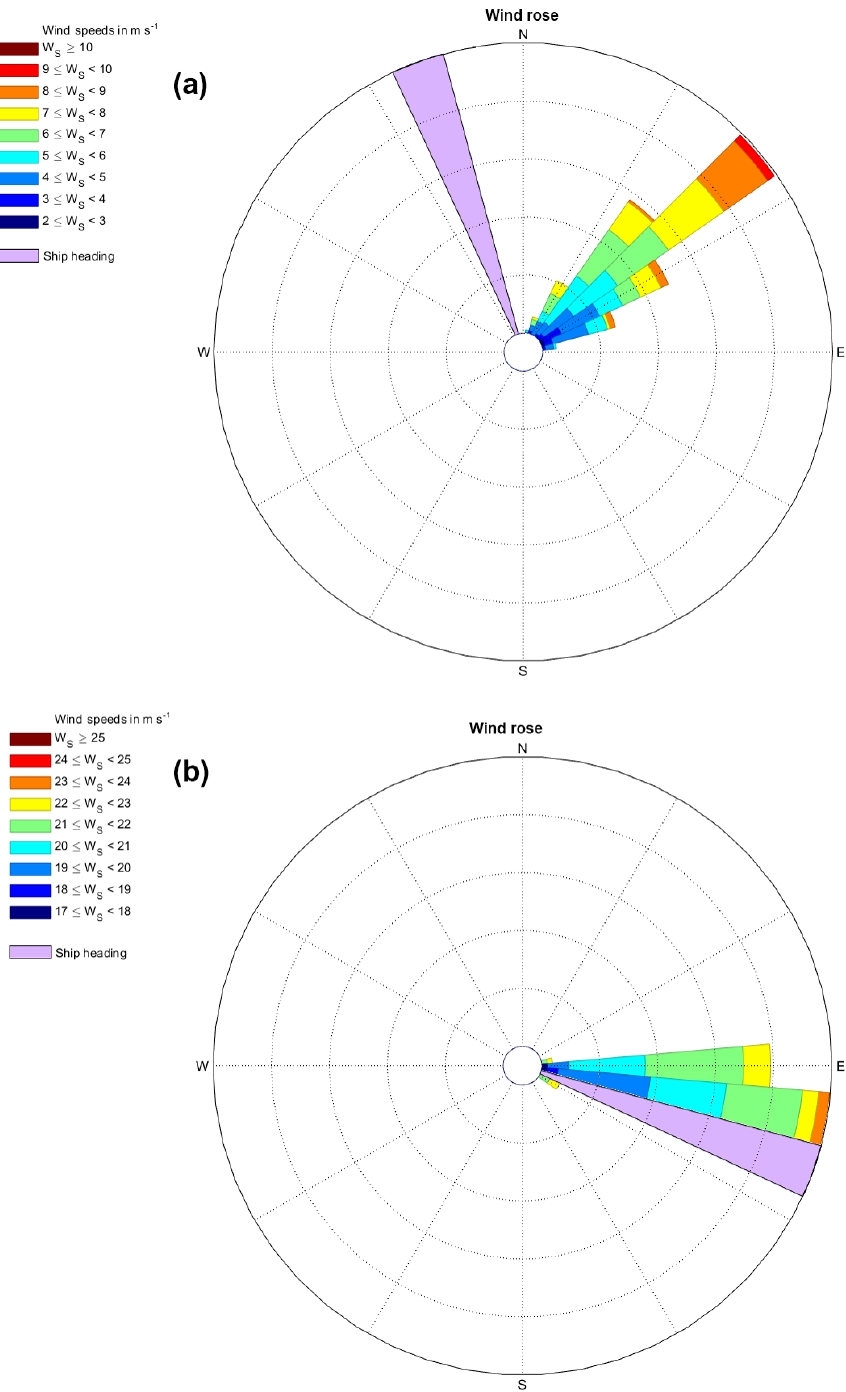
Figure 3. Wind rose showing wind speed and direction during optimized flight paths for day 1 (a) and day 2 (b) . The rose triangle shows the direction of RV Investigator during the